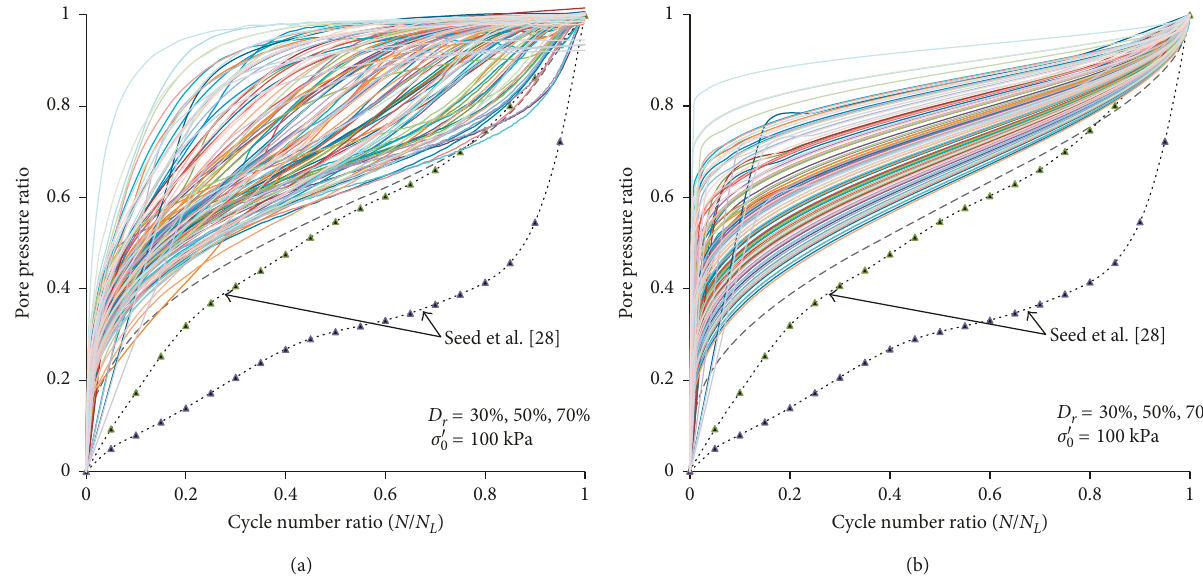
L ) obtained from the results of experiments. (b) Pore-